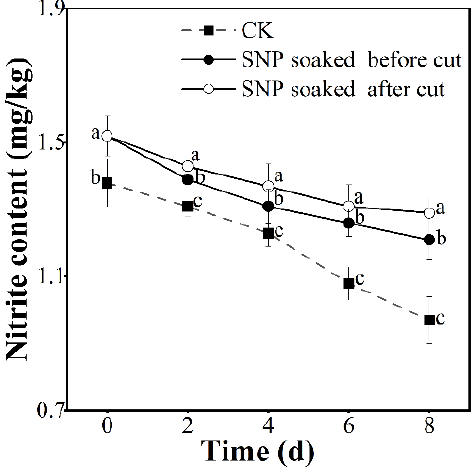
Figure 8. Effect of SNP treatment on nitrite content of fresh-cut potatoes. Different letters indicate significant differences among treatments at same storage time ( p < 0.05).